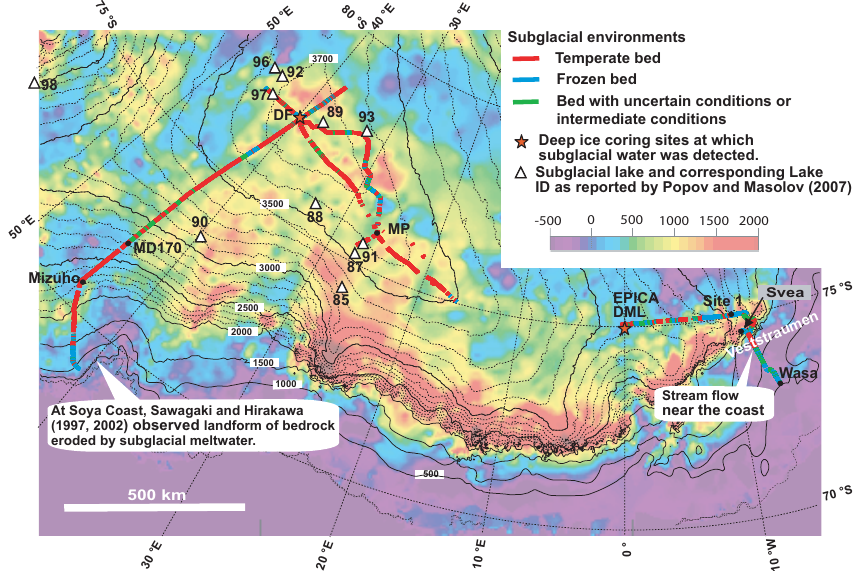
Fig. 10. Predicted bed conditions are shown on a bed topography map of DML for the same area shown in Fig. 1. The red, blue, and green dots indicate sites of temperate, frozen, and uncertain bed conditions, respectively. The bed topography map is from the BEDMAP compilation (Lythe et al., 2001), which does not reflect the new data. The bed elevation is shown by the colour scale. Surface elevation is shown by thin black contours. Known information related to subglacial conditions is given in the figure.